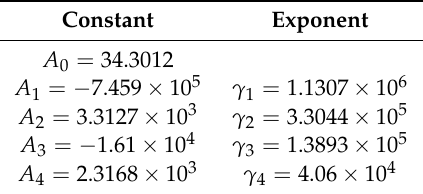
Table 3. Constant and exponent values of the fractional-order PID controller in time domain.